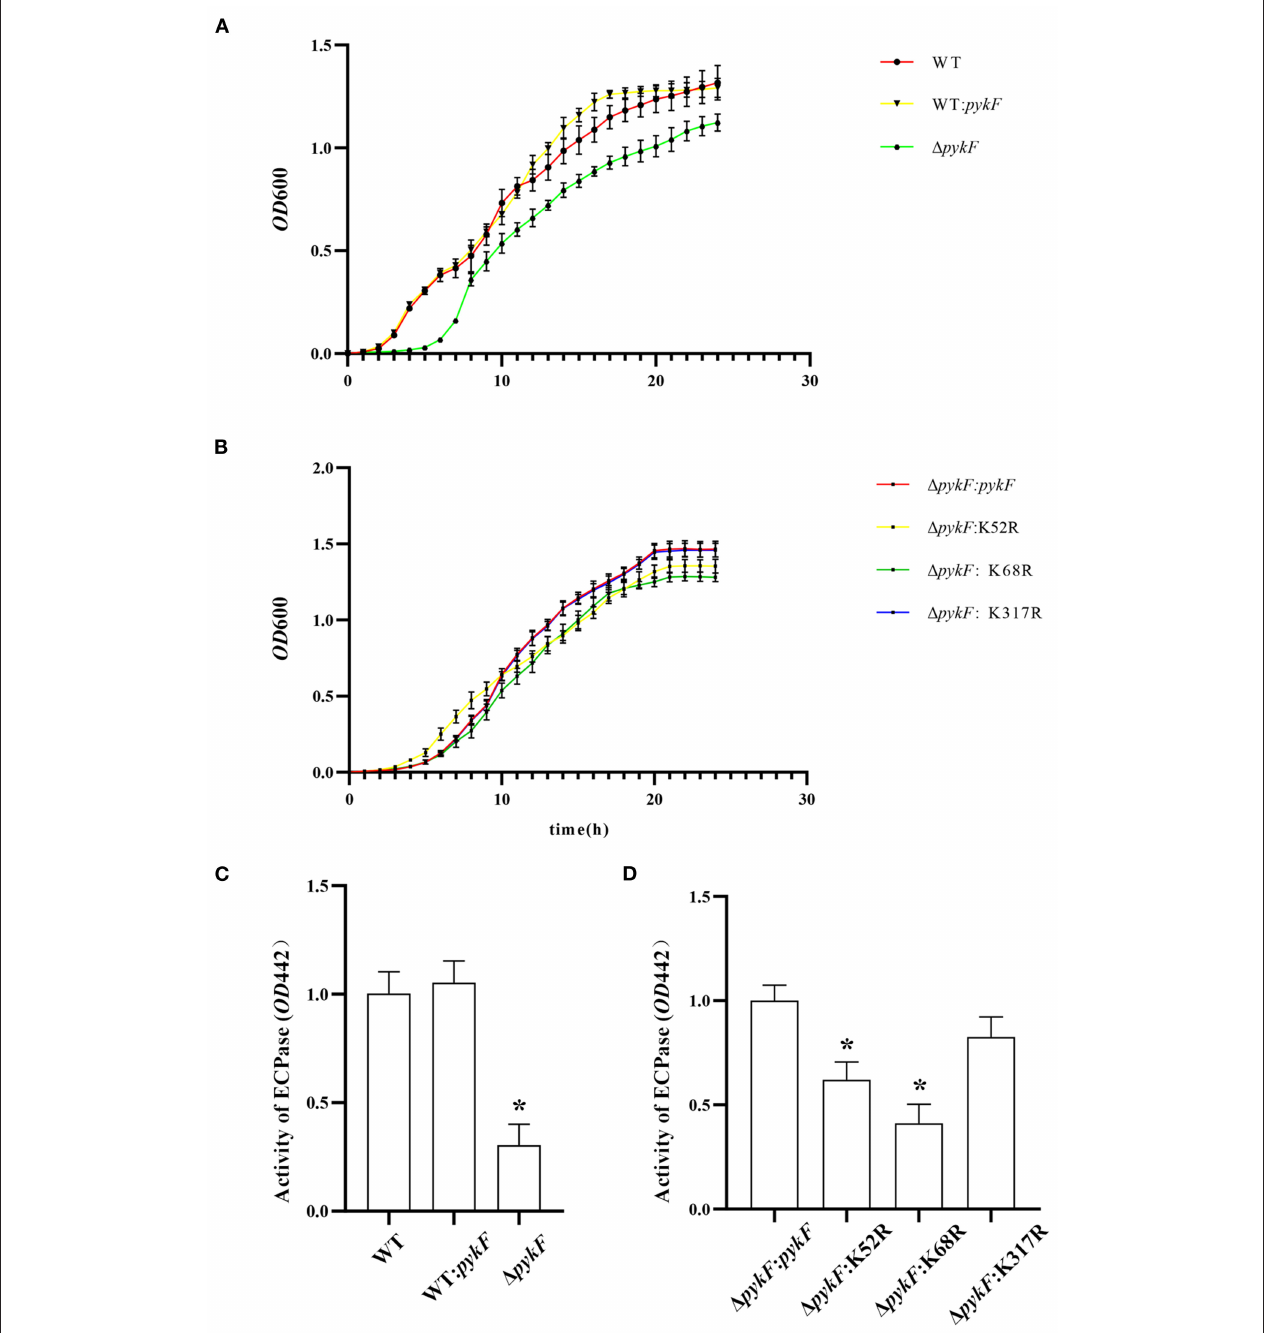
FIGURE 5 | (A) Growth of V. alginolyticus . Analysis of growth throughout the V. alginolyticus 1 pykF strain and WT: pykF overexpression strain at 24h. (B) Analysis of growth throughout V. alginolyticus 1 pykF : pykF , 1 pykF :K52R, 1 pykF : K68R and 1 pykF :K317R complemented strains at 24h. (C) Analysis of extracellular protease activity throughout the V. alginolyticus 1 pykF mutant strain and WT: pykF overexpression strain. Extracellular protease activity of V. alginolyticus WT was set as 1. (D) Analysis site-directed mutagenesis complemented strains on extracellular protease activity. Extracellular protease activity of V. alginolyticus 1 pykF:pykF was set as 1. Mean values and standard deviations were calculated based on three replicates ( n = 3). Two-tailed P -values were determined by the t -test, and the significance level is 0.05. * p < 0.05.